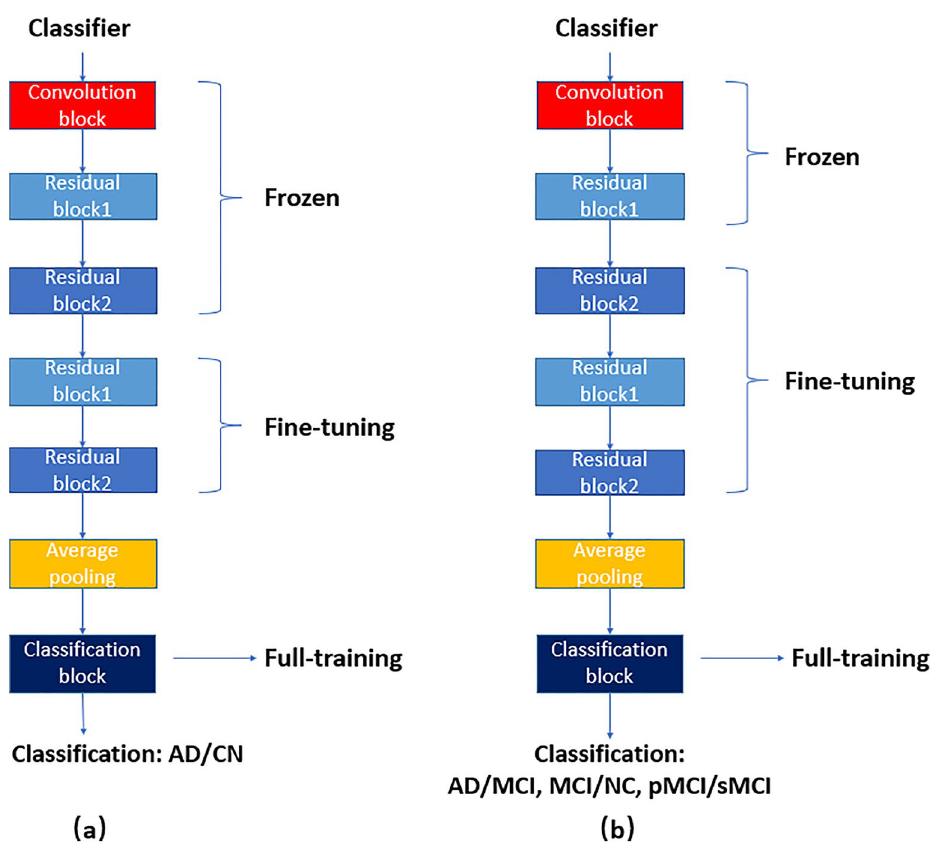
Figure 3. The network architecture of